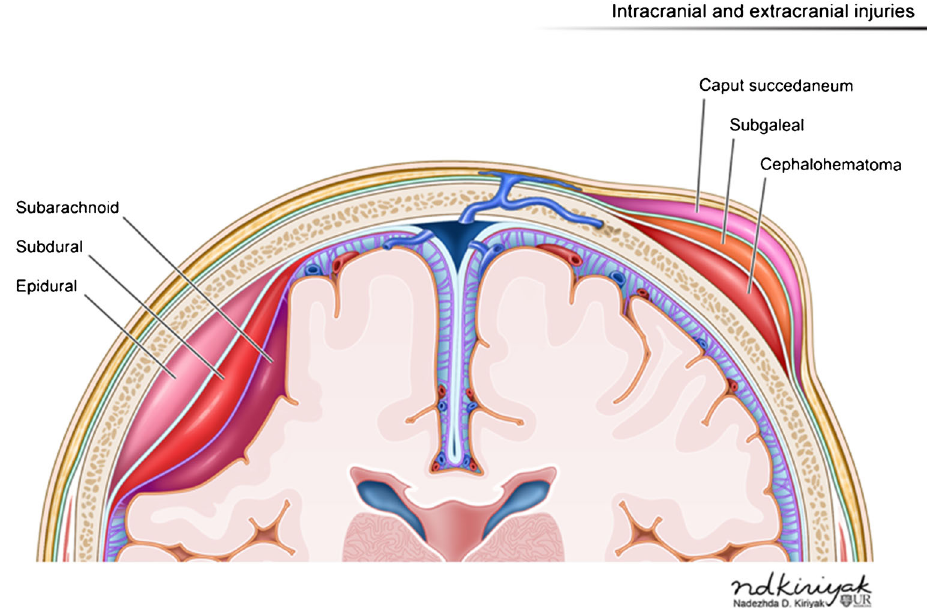
Fig. 2 Illustration depicting hemorrhages by location within the different layers of the meninges (left of image) and scalp (right of